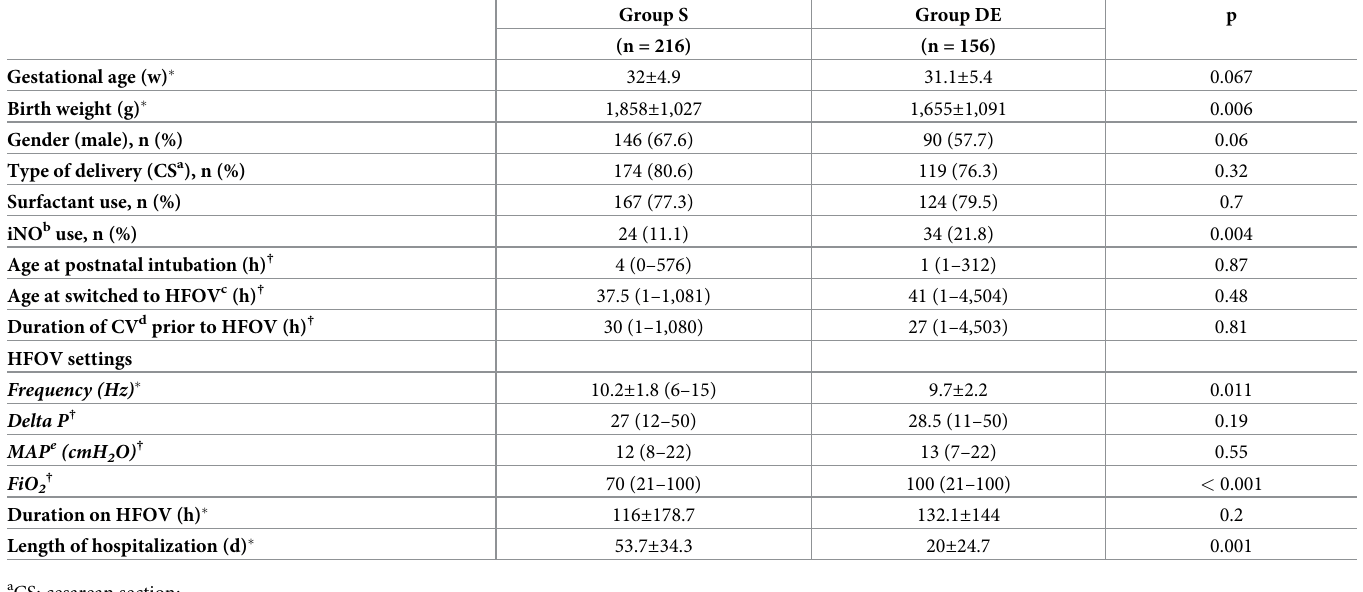
Table 1. The comparison of groups according to clinical findings.